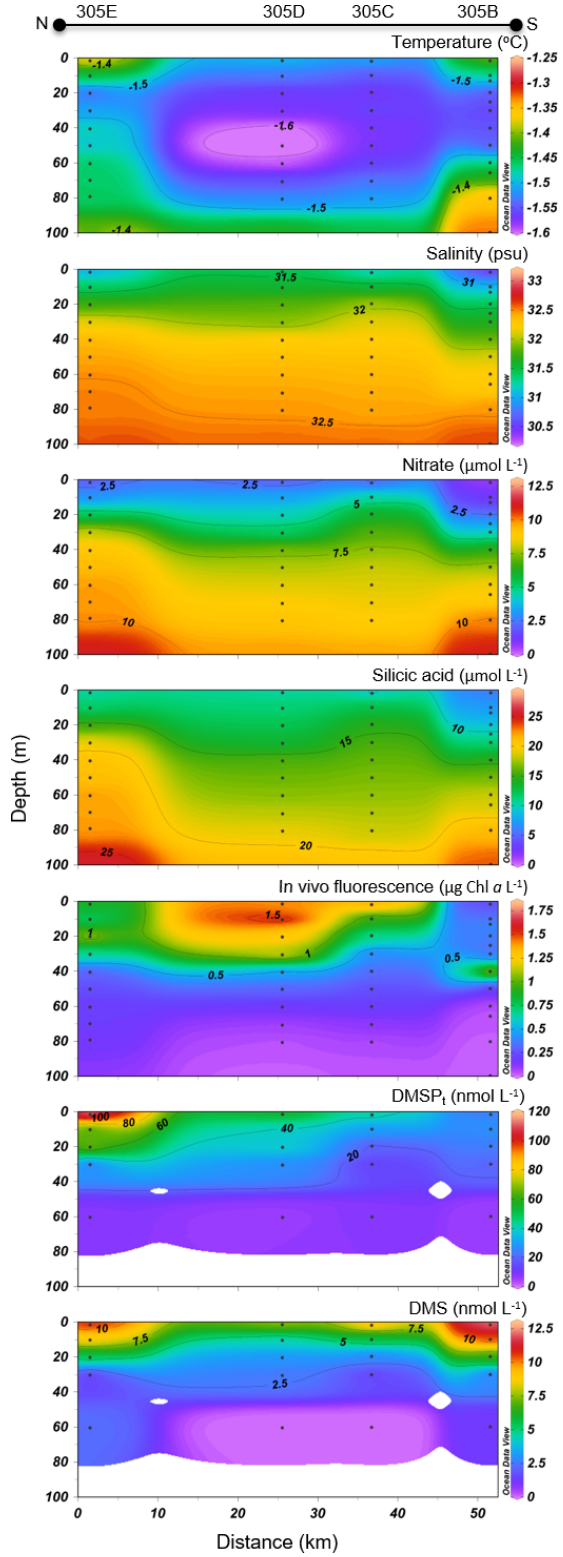
Figure 4. Barrow Strait (BS) cross section of the vertical distribu- tions of temperature, salinity, nitrate, silicic acid, in vivo fluores- cence, DMSP t , and